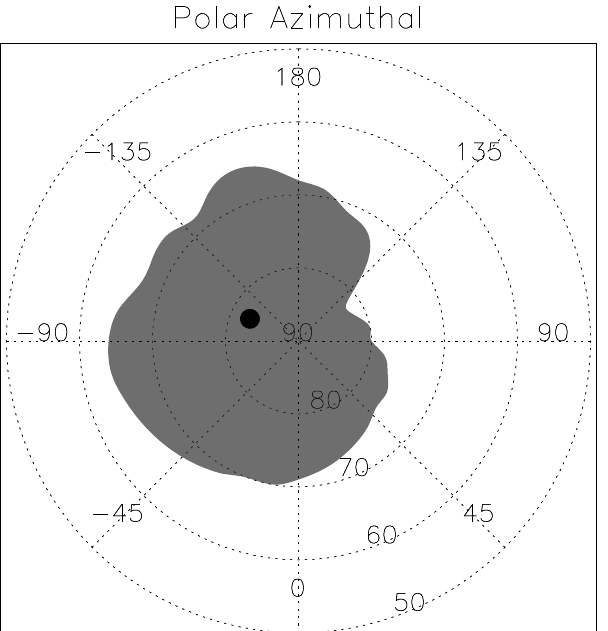
Figure 3. The CRW indicated by the shaded region, with the big dot indicating the north magnetic pole.